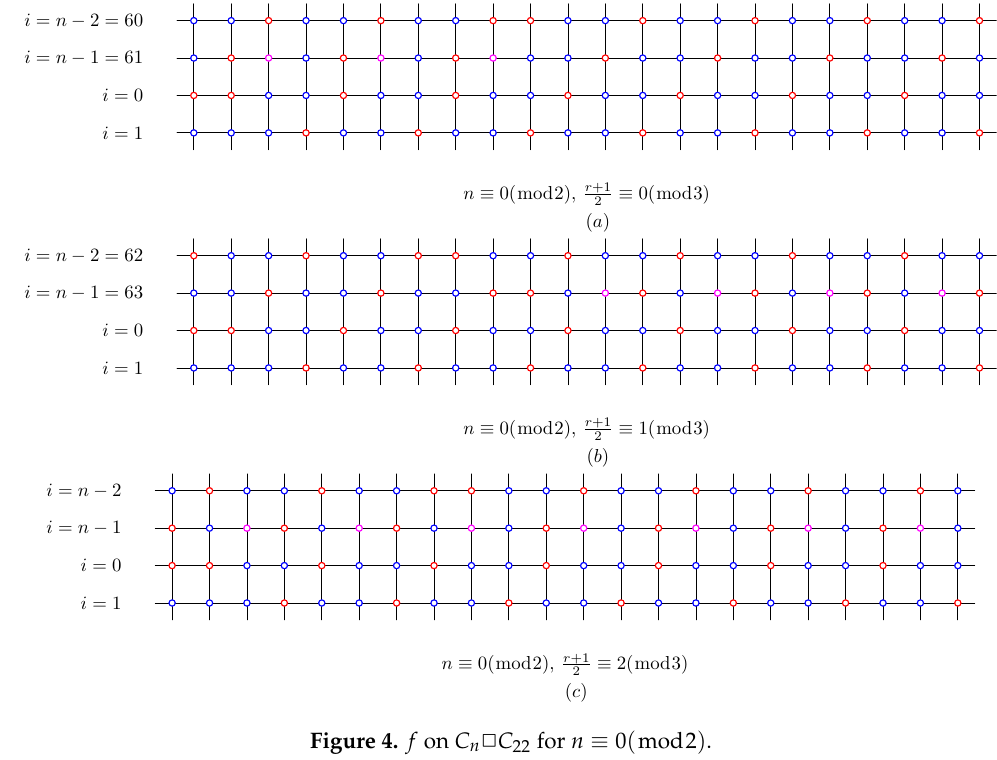
Figure 4. f on C n 2 C 22 for n